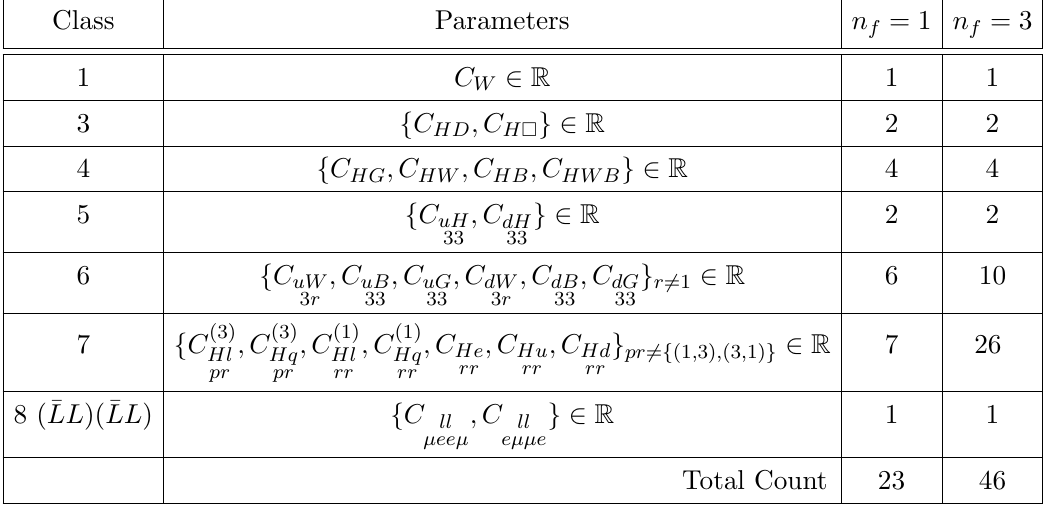
Table 5 . LO parameter counts in the general SMEFT (cid:13)avour cases for n f generations for a ‘WHZ pole parameter’ program. The parameters retained are those that lead to contributions to near on-shell regions of phase space, do not experience suppressions by light quark mases or GIM suppression when interfering with the SM, or violate CP and carry a resonant enhancement in this region of phase